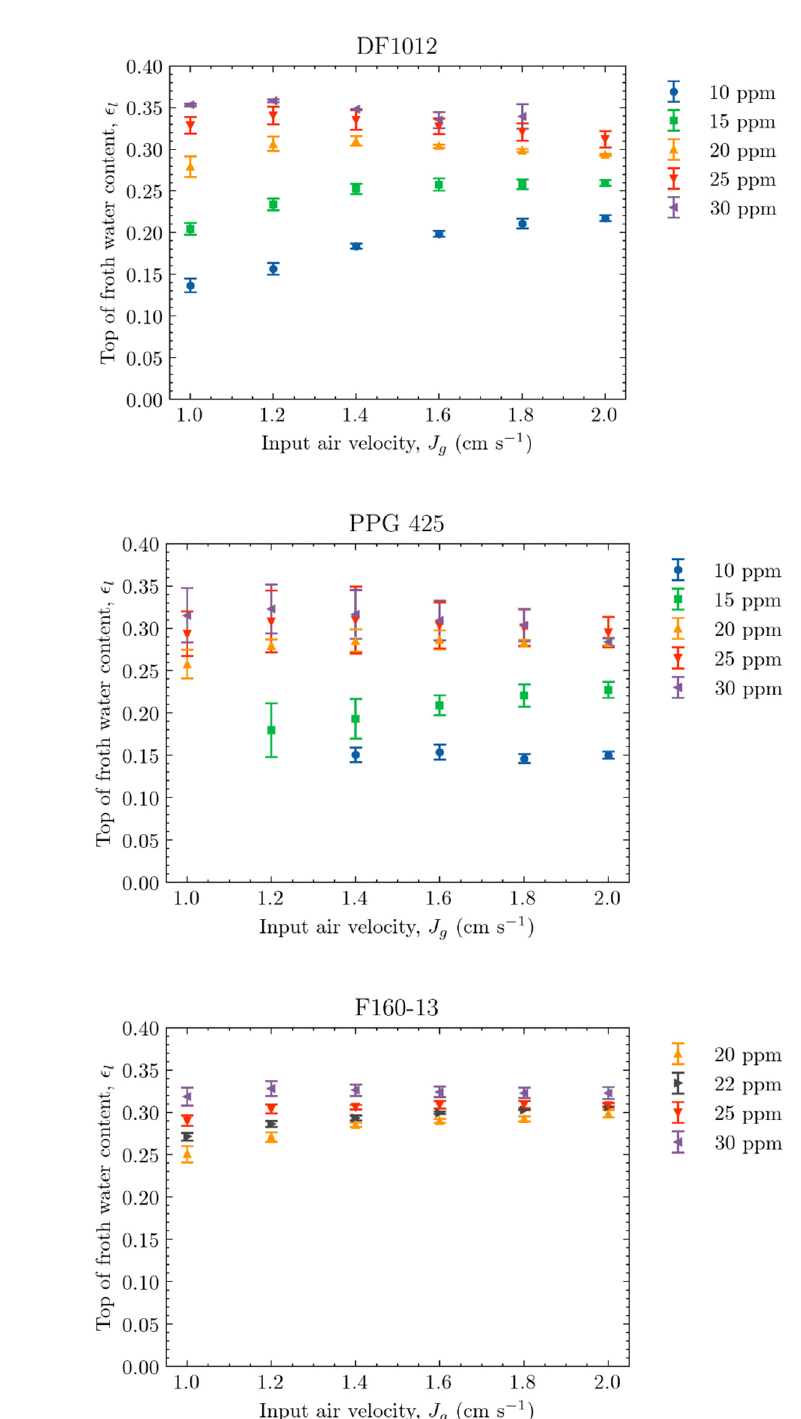
Figure 11. Measured froth water content under various operating conditions for ( a ) DF1012, ( b ) PPG 425 and ( c ) F160-13, at various frother concentrations.